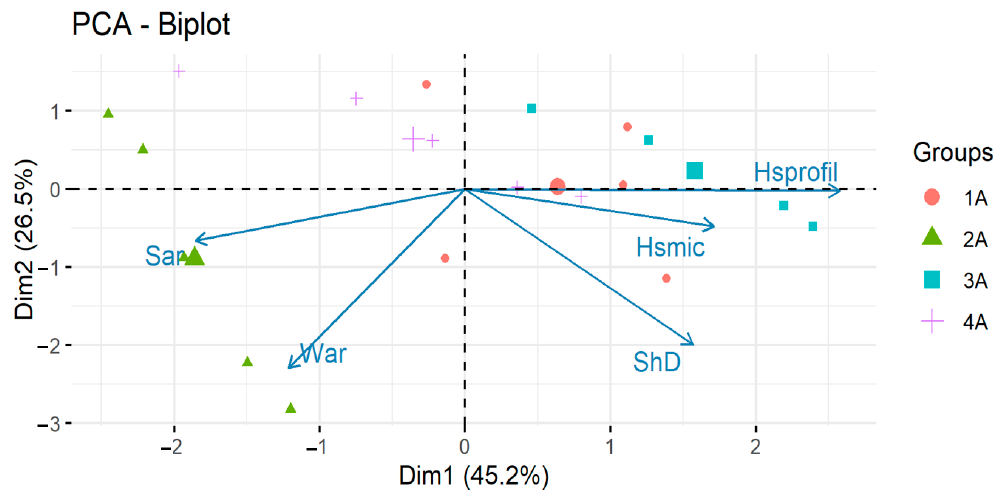
Figure 14. Vectors of original variables.